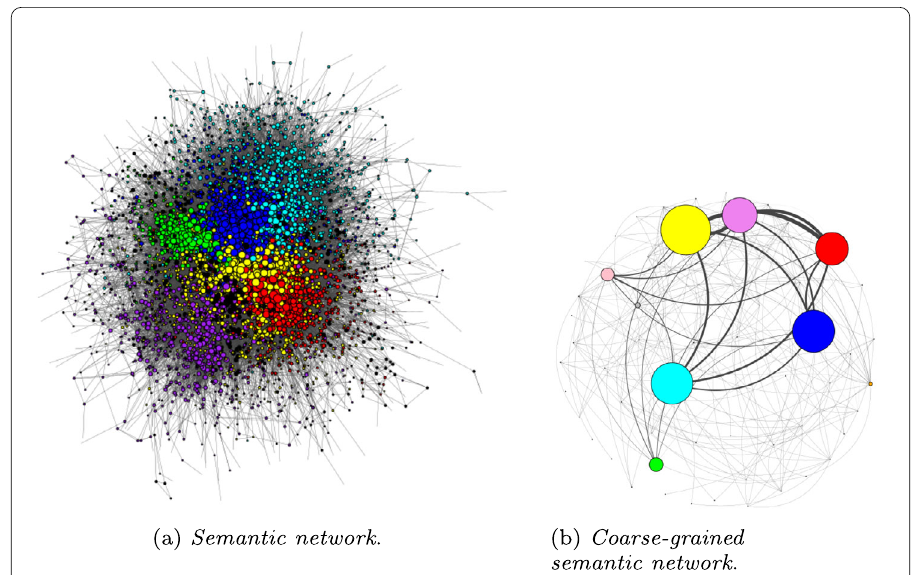
Figure 4 Thevalidatedsemanticnetwork . In panel ( a ) each node represents a different hashtag. We assigned a different color to the six most numerous communities, which are described in the main text, and the remaining nodes are colored black. The dimension of the nodes is proportional to their degree. The panel ( b ) shows a coarse grained representation of the network of panel ( a ): hyper-nodes represent the various communities of hashtags and their dimension is proportional to their numerosity. The edges are weighted according to the number of users that shared hashtags from both the connected communities. Both networks are represented using Fruchterman–Reingold